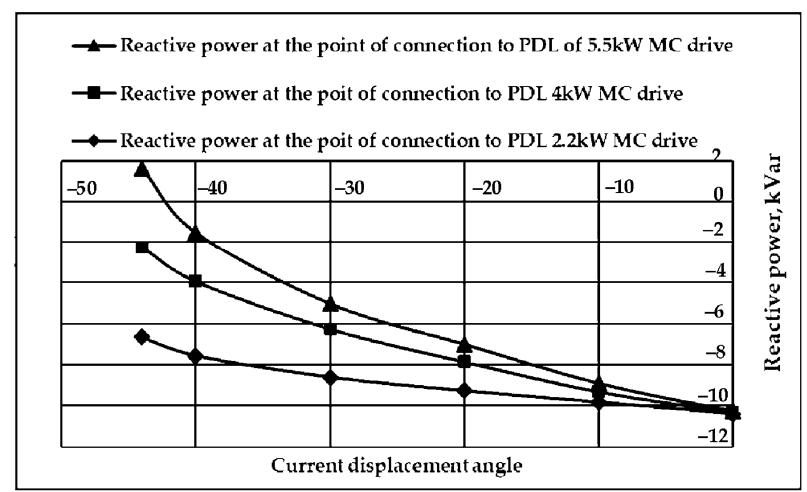
Figure 16. The reactive power at the point of the LED display and the MC-based VFD connection to the power distribution lines as a function of the current displacement angle. the power distribution lines as a function of the current displacement angle.